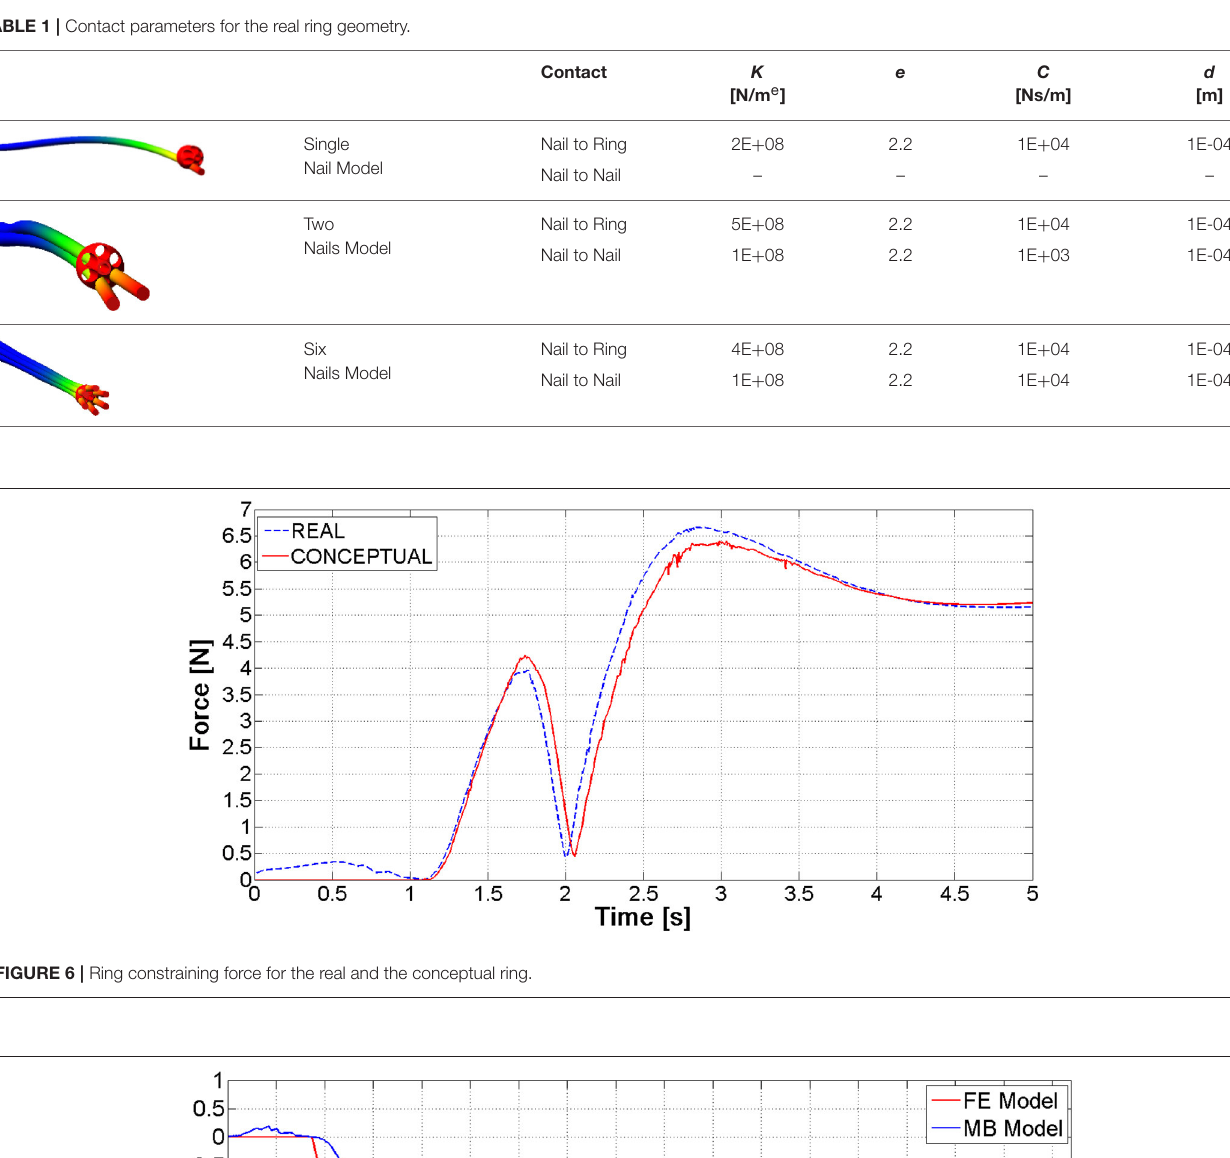
Frontiers in Bioengineering and Biotechnology | www.frontiersin.org